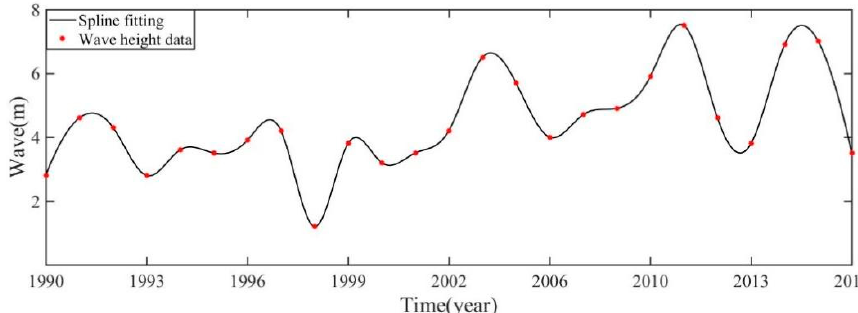
Figure 3. The wave height data scatter plot when Δ𝑡 = 1 .